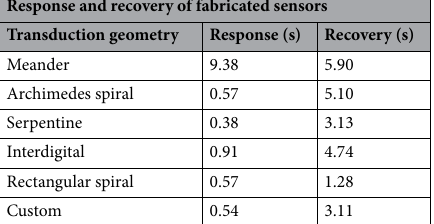
Table 4. Response and recovery of the transduction